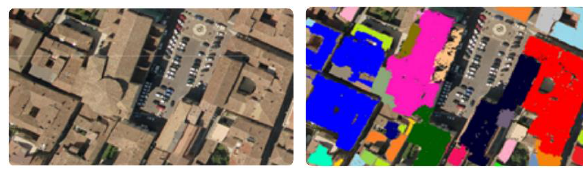
Figure 9. Image subset of airborne image (left) and